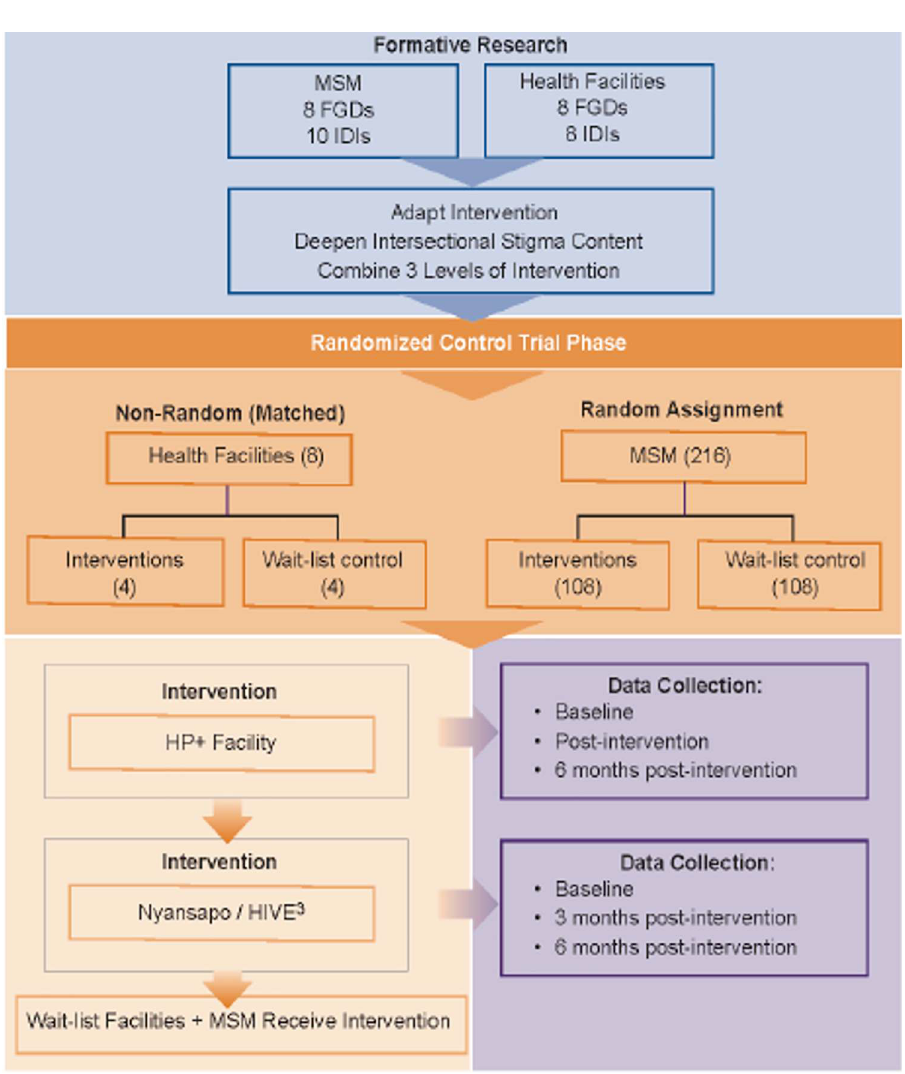
Fig 2. Diagram of study design for formative and randomized controlled trial